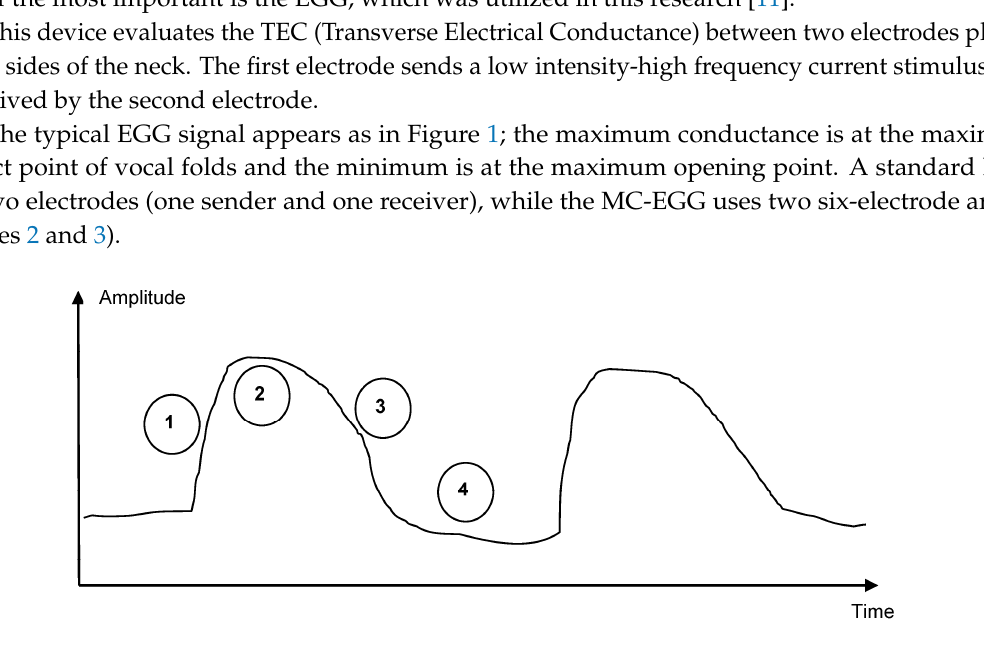
Figure 1. Phases of the idealized EGG waveform related to the vibratory cycle of the folds: 1: closing phase; 2: maximum contact; 3 opening phase; 4: open, no contact.